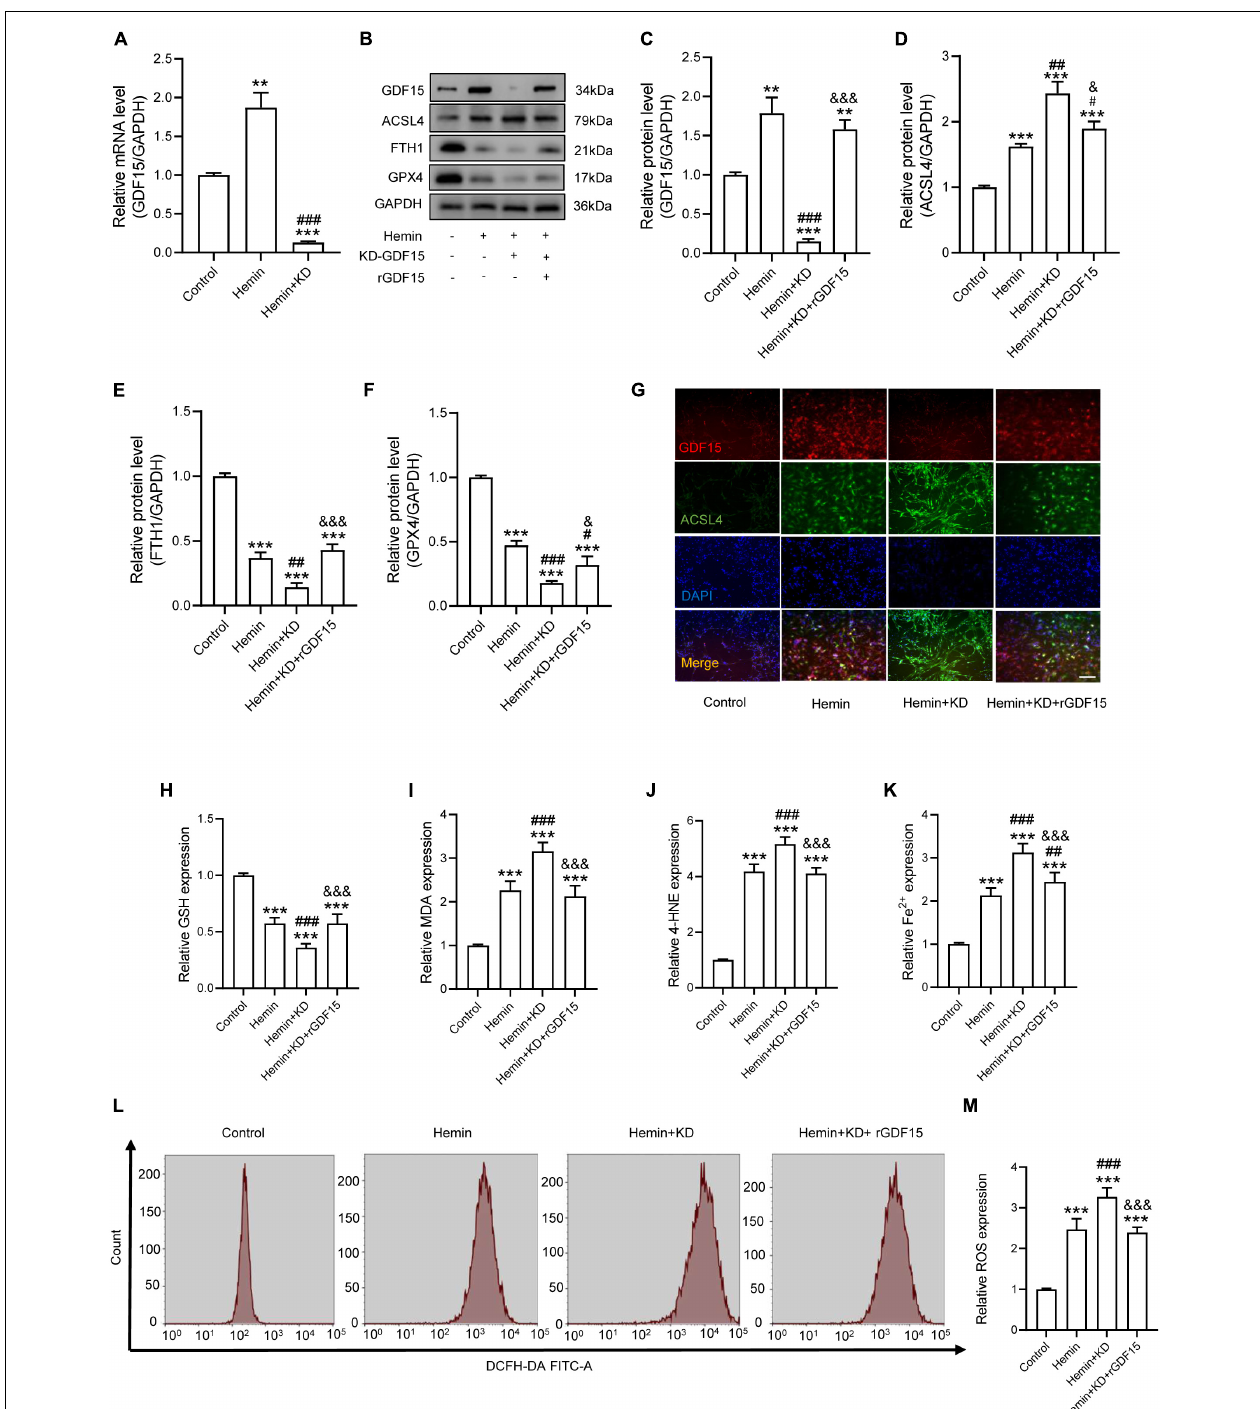
FIGURE 2 | GDF15 effectively alleviated oxidative stress-dependent neuronal ferroptosis in vitro . (A) Relative mRNA level of GDF15 after knockdown ( n = 6). (B) Western blotting performed for GDF15 and ferroptosis-associated proteins including ACSL4, FTH1, and GPX4 in Hemin-activated primary neurons after transfection of KD-GDF15 or adding rGDF15 ( n = 3). GAPDH was used as the control. (C–F) Bar graph showing quantitative analysis of GDF15, ACSL4, FTH1, and GPX4 ( n = 3). (G) Representative immunofluorescence labeling images for GDF15 (red) and ACSL4 (green) in Hemin-activated primary neurons after transfection of KD-GDF15 or adding rGDF15 (Scale bar = 50 µ m). (H–K) The values of GSH, MDA, 4-HNE, and Fe 2 + concentrations were determined ( n = 6). (L) The value of ROS was determined ( n = 6). (M) Bar graph showing quantitative analysis of ROS expression ( n = 6). The error bars represent the SD. ** p < 0.01, *** p < 0.001, vs. control group; # p < 0.05, ## p < 0.01, ### p < 0.001, vs. Hemin group; & p < 0.05, &&& p < 0.001, vs. Hemin + KD group by one-way ANOVA followed by Tukey’s post hoc analysis.